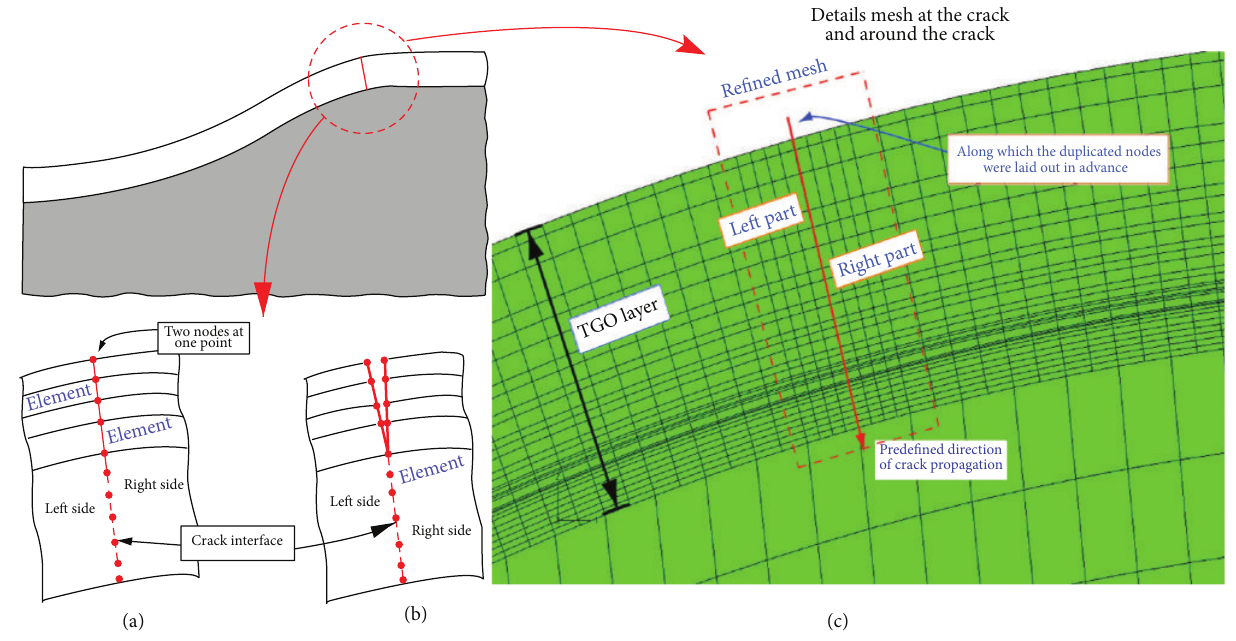
Figure 6: The crack model and the detail mesh at the